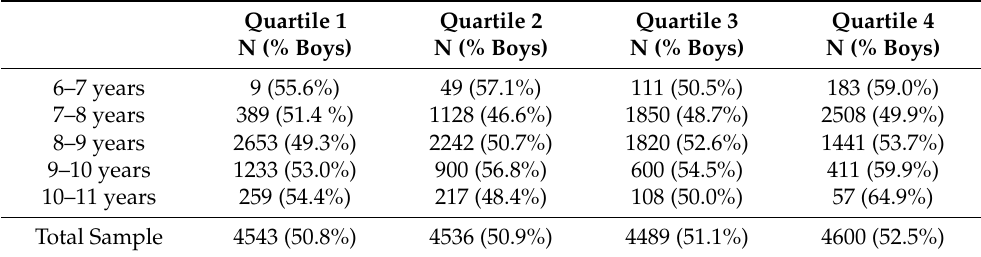
Table 1. Distribution of participants across age groups and age-specific